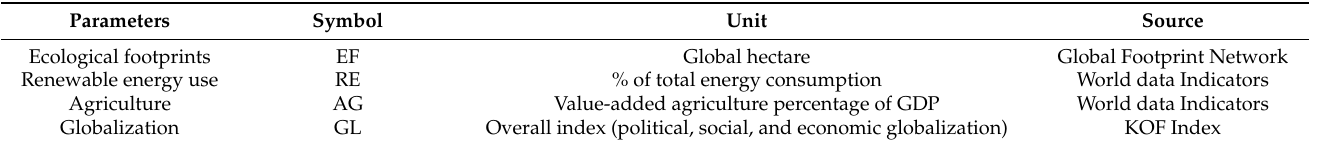
Table 1. Data sources and their description.